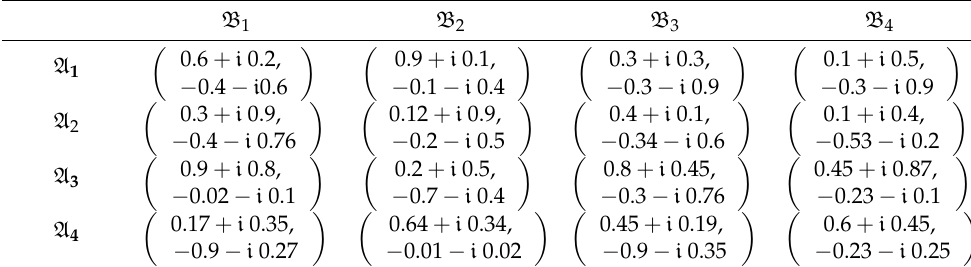
Table 1. Bipolar complex fuzzy